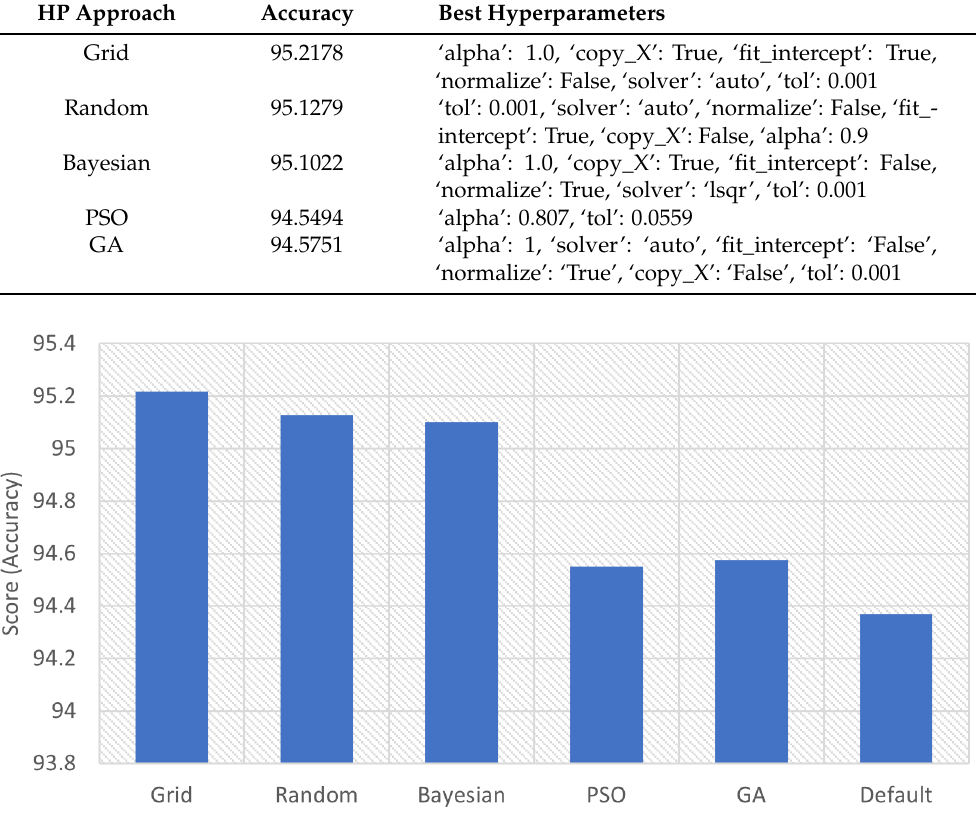
Figure 9. Hyperparameter tuning techniques versus score for Ridge Classifier